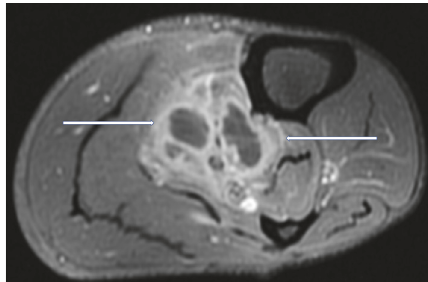
Figure 1: Axial, T2 weighted, fat saturated, STIR MR image showing loculated fluid signal within the tibialis posterior muscle (thick white arrows), suggestive of a collection. Also noted are diffuse T2 hyperintense signal changes in the surrounding musculature (thin white arrows), compatible with myositis.